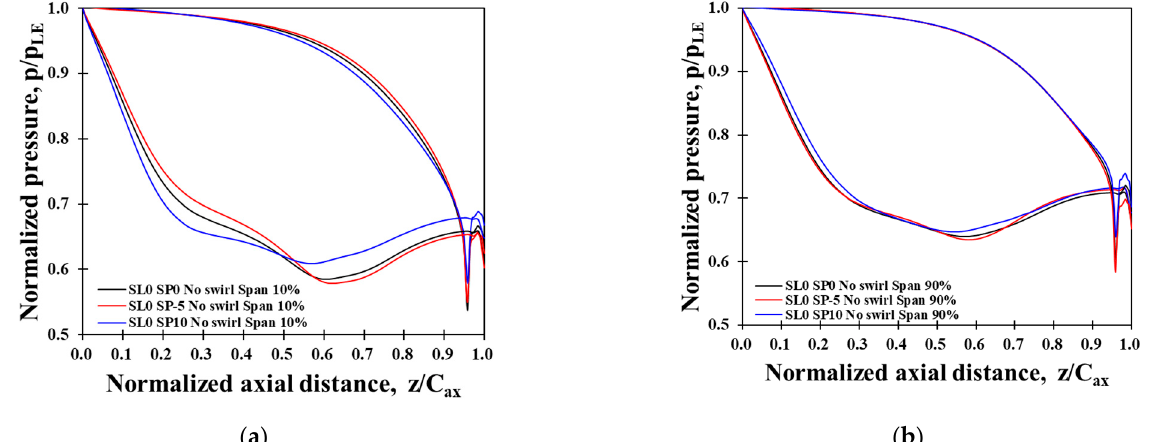
Figure 15. Comparison of NGV loading due to sweep angle: ( a ) Span height 10%; ( b ) Span height 90%.